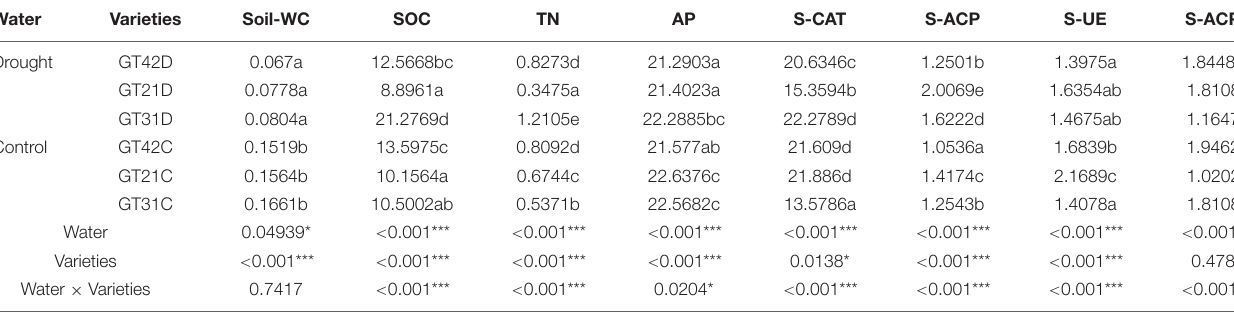
TABLE 2 | The physiological status of sugarcane under different treatments was significantly